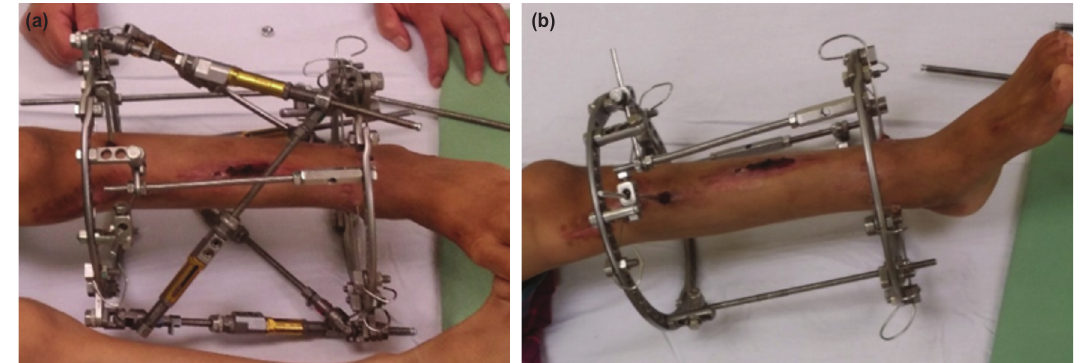
(a) Triple hinge pillar attached on the SUV frame prior to removal of struts. (b) All struts have been removed and replaced with Fig. 3: three triple hinge